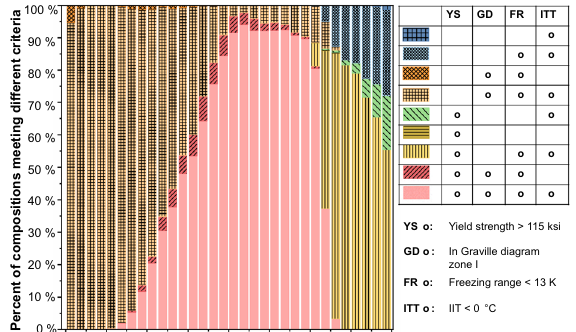
Fig. 6 Optimization of carbon content by visualizing the percentages of compositions meeting different criteria. Pink color without pattern fi lling: The percentage of compositions with yield strength higher than 115 ksi, good weldability, and ITT lower than 0 K. The meaning of other color and pattern- fi lled bars can be understood in a similar way based on the table in the fi gure, and groups smaller than 0.1% are not listed for better illustration.